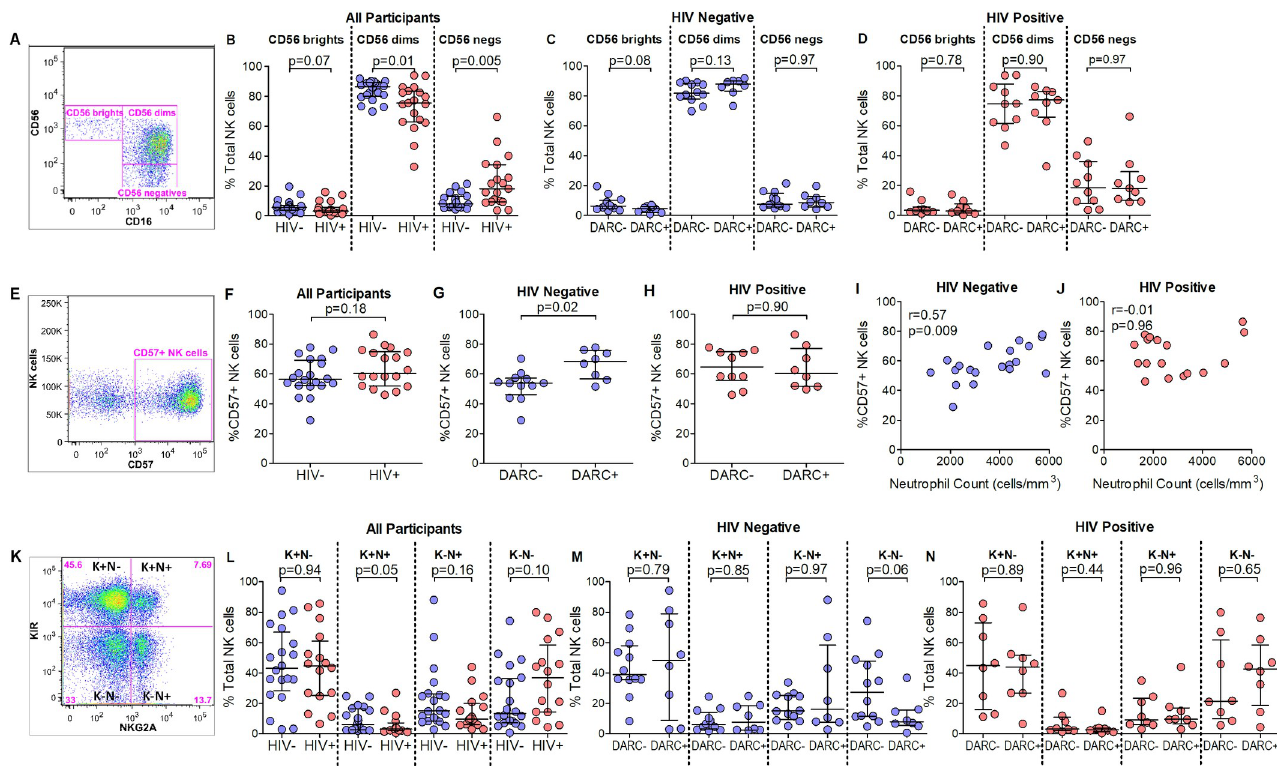
Fig 2. NK cell subset frequencies and markers of differentiation. (A) Total NK cells grouped by relative CD56 and CD16 expression into CD56 bright, CD56 dim and CD56 negative subsets. (B) NK cell subset frequencies in all participants. NK cell subset frequencies stratified by DARC genotype in HIV negative (C) and HIV positive (D) individuals. (E) Gating strategy for CD57 expressing NK cells as a percentage of total NK cells. (F) CD57 expressing NK cells as a percentage of total NK cells in all participants. CD57 expressing NK cells as a percentage of total NK cells stratified by DARC genotype in HIV negative (G) and HIV positive (H) individuals. Correlations between CD57 expressing NK cells and ANCs are shown in HIV negative (I) and HIV positive (J) individuals. (K) Representative strategy employed for the identification of KIR and/or NKG2A expressing NK cells. (L) KIR/NKG2A subsets as a percentage of total NK cells in all participants. KIR/NKG2A subsets further stratified by DARC genotype in HIV negative (M) and HIV infected (N) individuals. Dots indicate individual data points. Medians are indicated and extended to interquartile range with whiskers. Abbreviations: DARC, Duffy antigen receptor for chemokines; K+N-, KIR +NKG2A- NK cell subset; K+N+, KIR+NKG2A+ NK cell subset; K-N+, KIR-NKG2A+ NK cell subset; K-N-, KIR-NKG2A- NK cell subset.